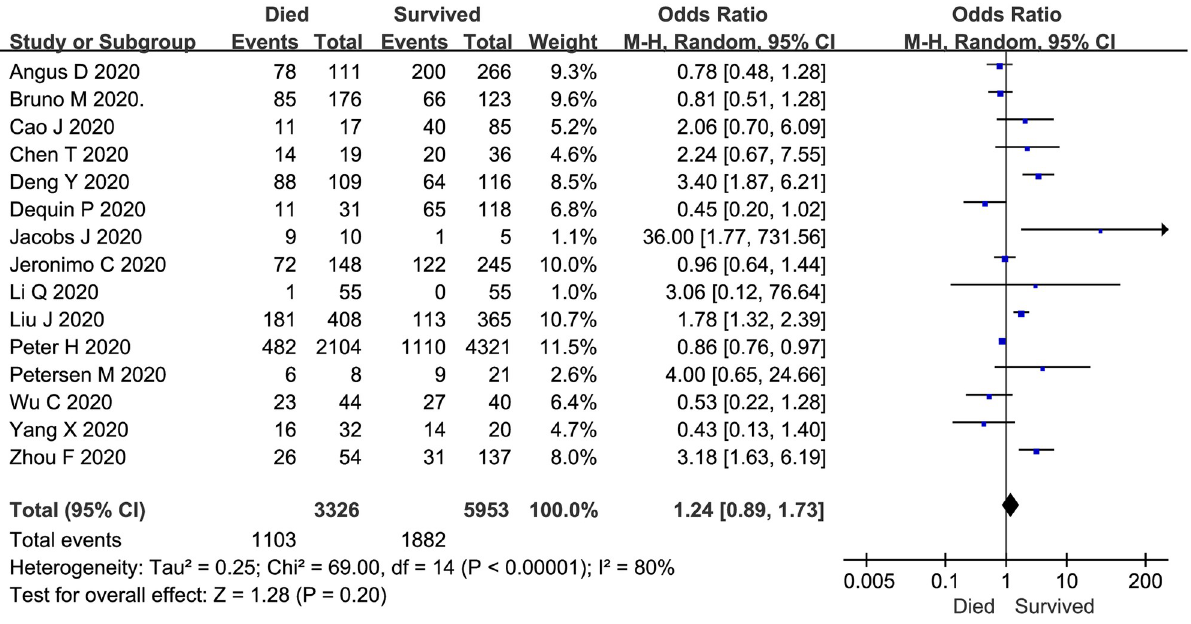
Fig 5. Corticosteroid vs. no corticosteroid treatment: Mortality of studied subjects (both groups received corticosteroids).